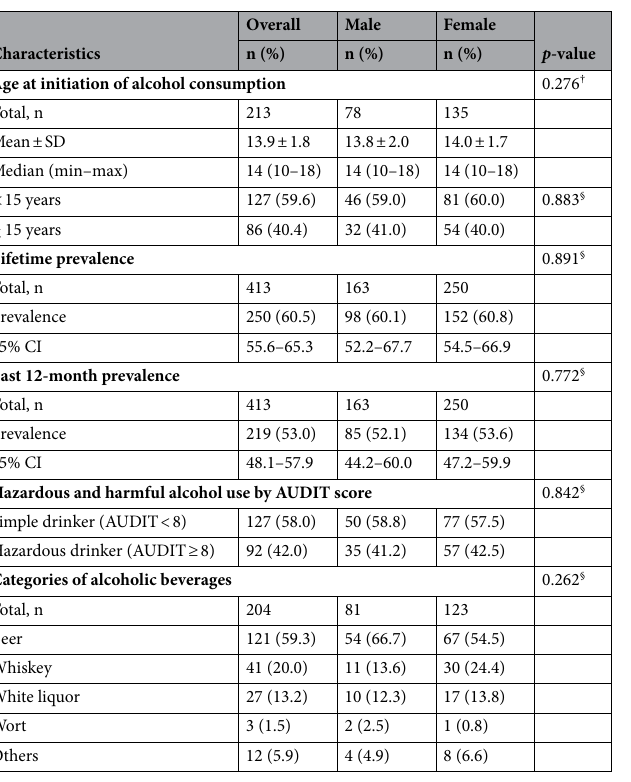
Table 2. Characteristic of alcohol consumption among adolescents in a rural community, central, Thailand. SD standard deviation. † t -test (male vs female). § Chi -square test (male vs